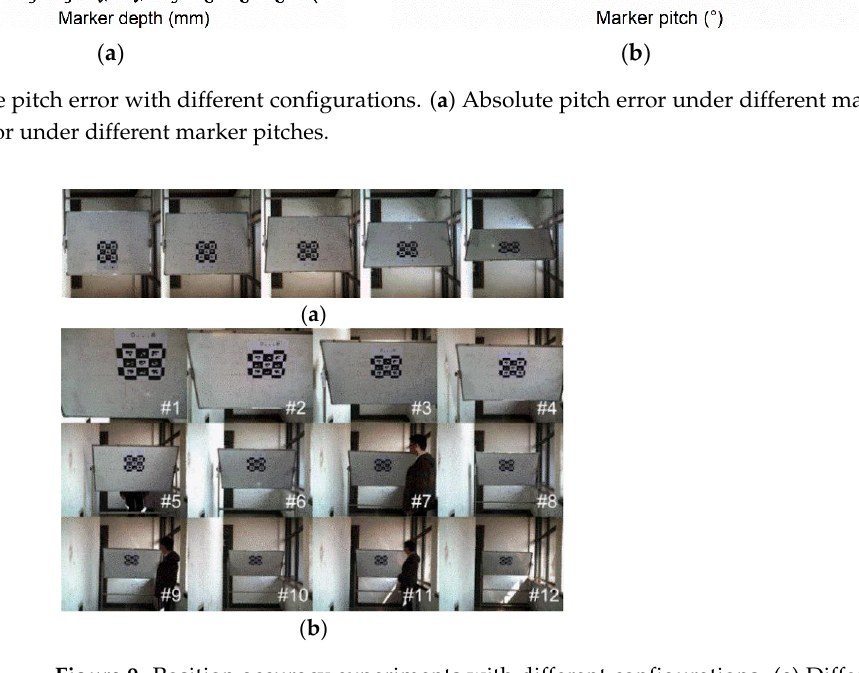
( b ) Figure 9. Position accuracy experiments with different configurations. ( a ) Different marker pitch. ( b ) Different marker depth. # 1 to 12 represents change in depth from 1963 to 7558 mm.